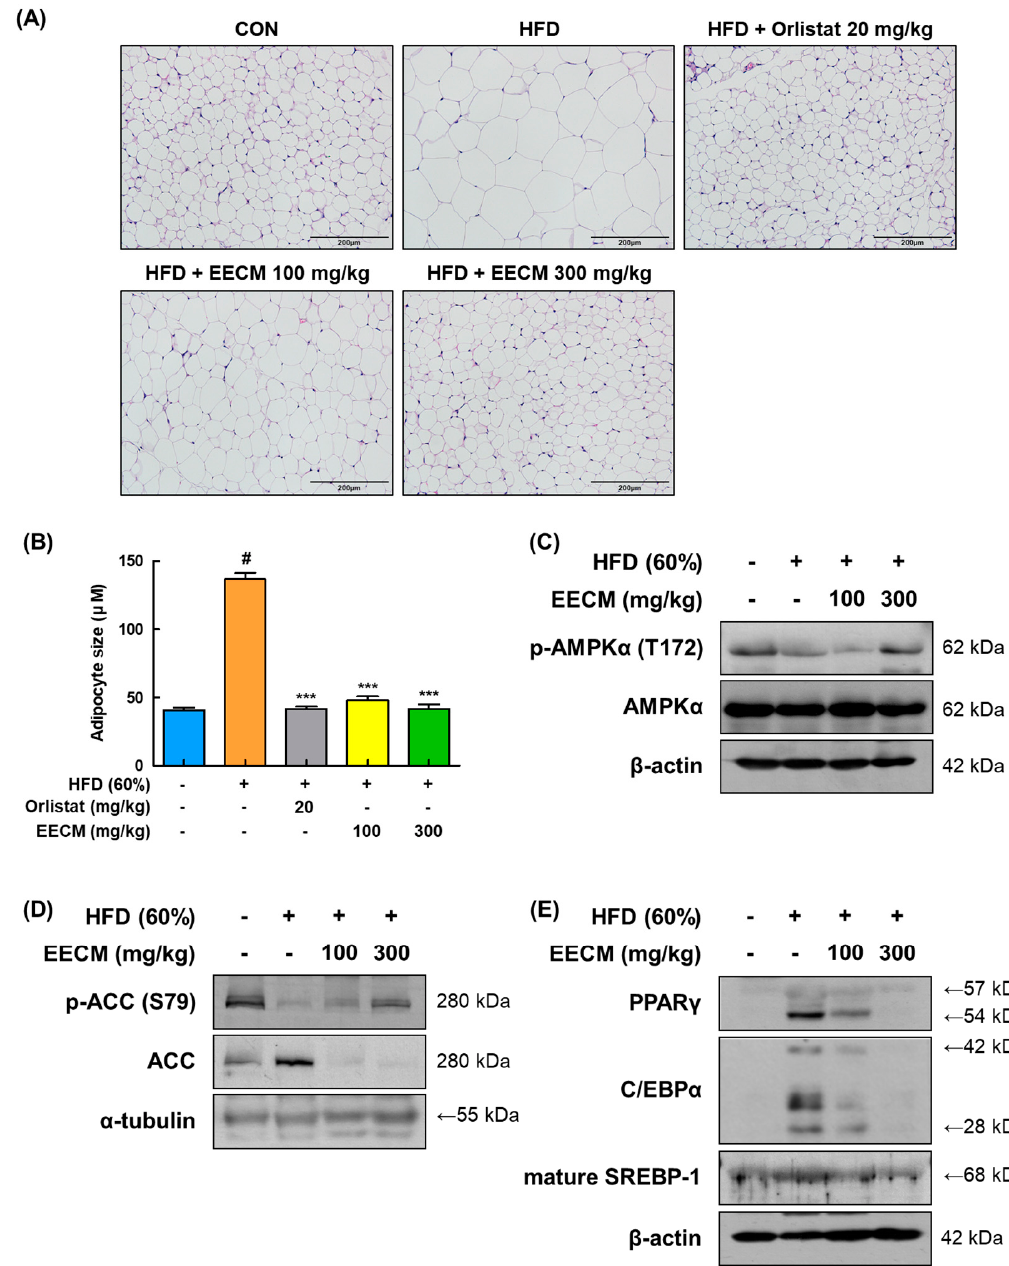
Figure 7. Effects of EECM on adipocyte size, adipogenesis, and lipogenesis in the subcutaneous fat tissues of HFD (60%)-induced obese mice. ( A ) Histological analysis of subcutaneous fat tissue via H&E staining at ×20 magnification. ( B ) Representative diameter of adipocytes in the tissue. Expression levels of ( C ) p-AMPK α , ( D ) lipogenic proteins, and ( E ) adipogenic transcription factors were determined via Western blotting analysis. Values are represented as the mean ± SEM ( n = 8/group). # p < 0.05 vs. the CON group; *** p < 0.001 vs. the HFD (60%)-induced obese group.